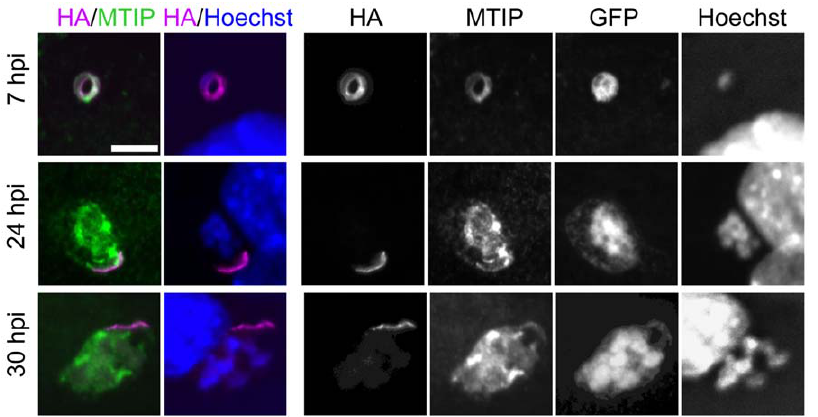
Figure 2. IMC1h-HA localisation in liver stages. Confocal images of intracellular parasites in Hepa 1–6 cells (7, 24, and 30 hpi) after immunofluorescence staining for HA, MTIP, GFP and DNA staining with Hoechst. At 7 hpi IMC1h-HA colocalises with MTIP lining the IMC of the transforming sporozoite. At 24 hpi IMC1h-HA is restricted to a narrow streak at the very edge of the parasitophorous vacuole and still colocalises with MTIP. This area is further reduced at 30 hpi. Scale bar=5 m m.